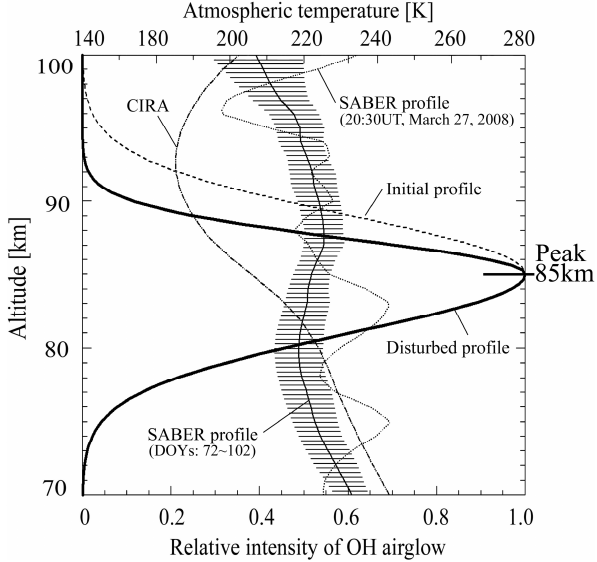
Fig. 4. Illustration of mechanisms which modify observable variations in rotational temperature and intensity of the OH airglow. The SABER temperature obtained near the Syowa station (dotted line), the 30-day averaged (thin solid line with error bars) temperature, and the zonal mean temperature (dot-dashed line) profile for March at 70 ◦ S obtained from the CIRA86 atmospheric model are plotted. The initial profile of the OH airglow emission rate is based on the data from the SABER/TIMED (see text).